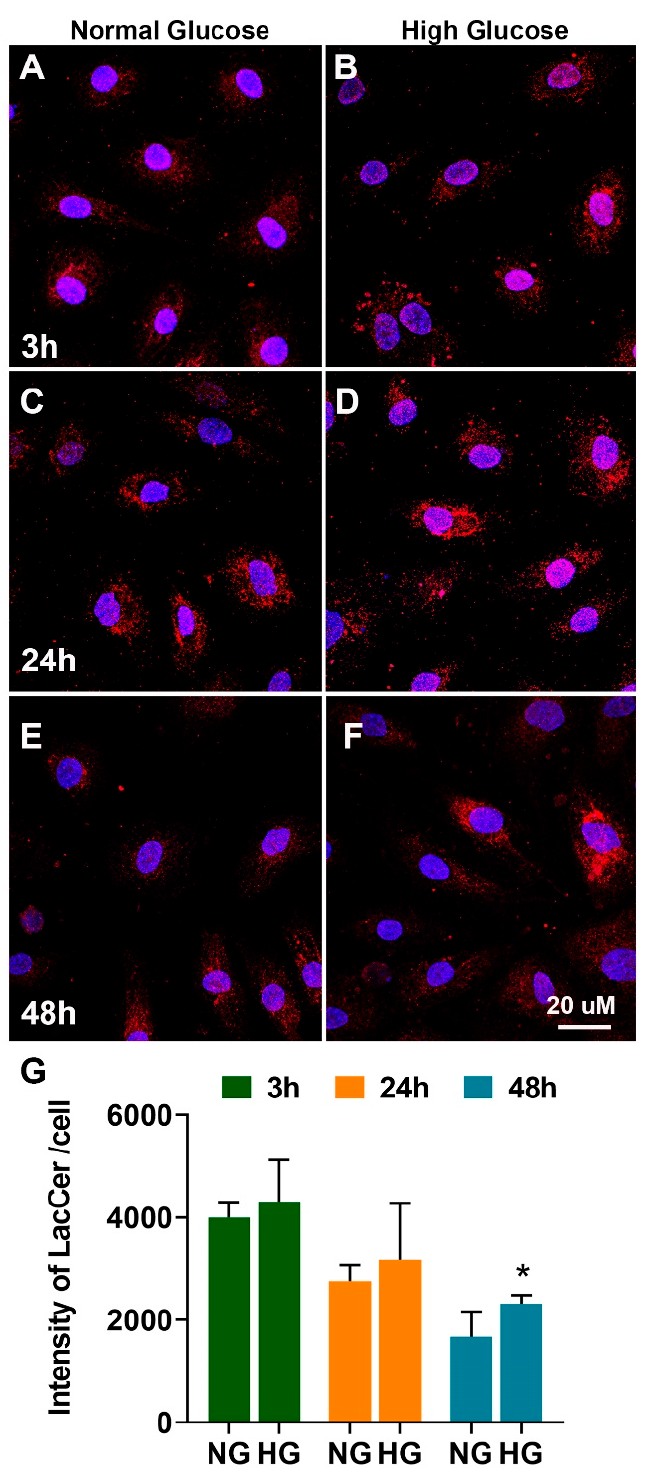
Figure 4. Immunohistochemical staining of LacCer in HREC cultured in 5 mM glucose (normal glucose) or 25 mM glucose (high-glucose) media for 3, 24, and 48 h. Confocal micrographs show LacCer (CD17) in red and nuclei (DAPI) in blue ( A – F ). LacCer labeling was quantified by ImageJ analysis and expressed as intensity/cell from 5–6 fields per condition and from at least 3 independent experiments ( G ). * p < 0.05.